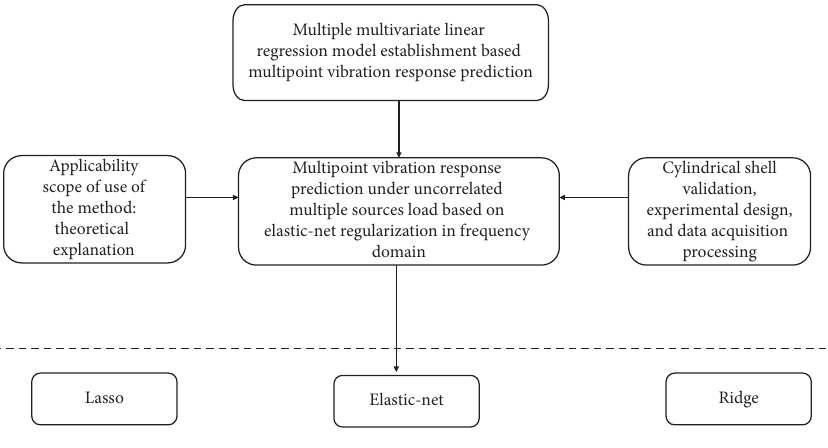
Figure 2: Flow chart of multiple linear regression prediction.